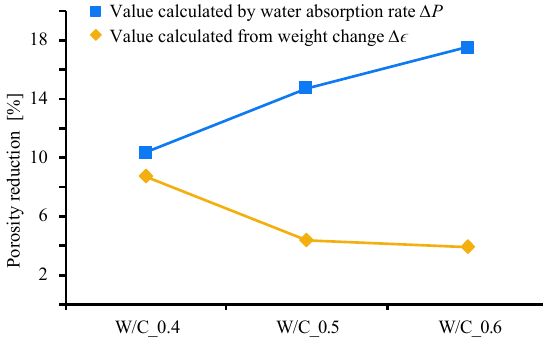
Figure 6. Comparison of porosity reduction ratios calculated two ways.